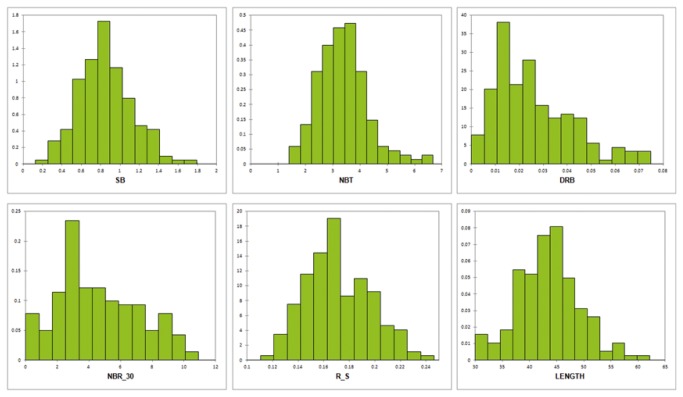
Distribution of selected traits.SB =shoot biomass; NBT = Tiller number; DRB = deep root biomass; NBR_30 = number of roots below 30 cm; R_S = root/shoot mass ratio; LENGTH = maximum root length .